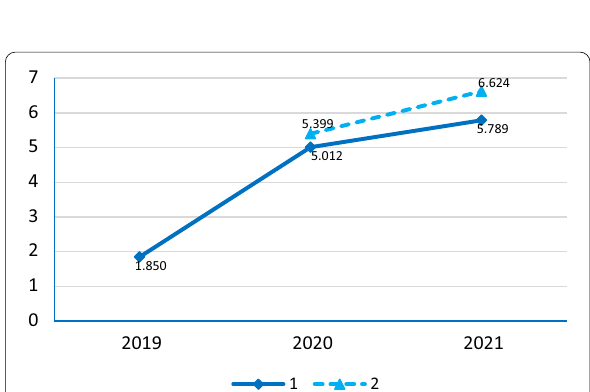
Fig. 1 Scopus metrics by calendar year (note: 1 2 SNIP, 3 SJR). Source: scopus.com website = =